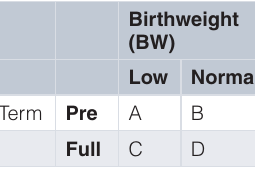
Table 1. Four combinations in total for exposure: a : Pre, Low; b : Pre, Normal; c : Full, Low and d : Full,